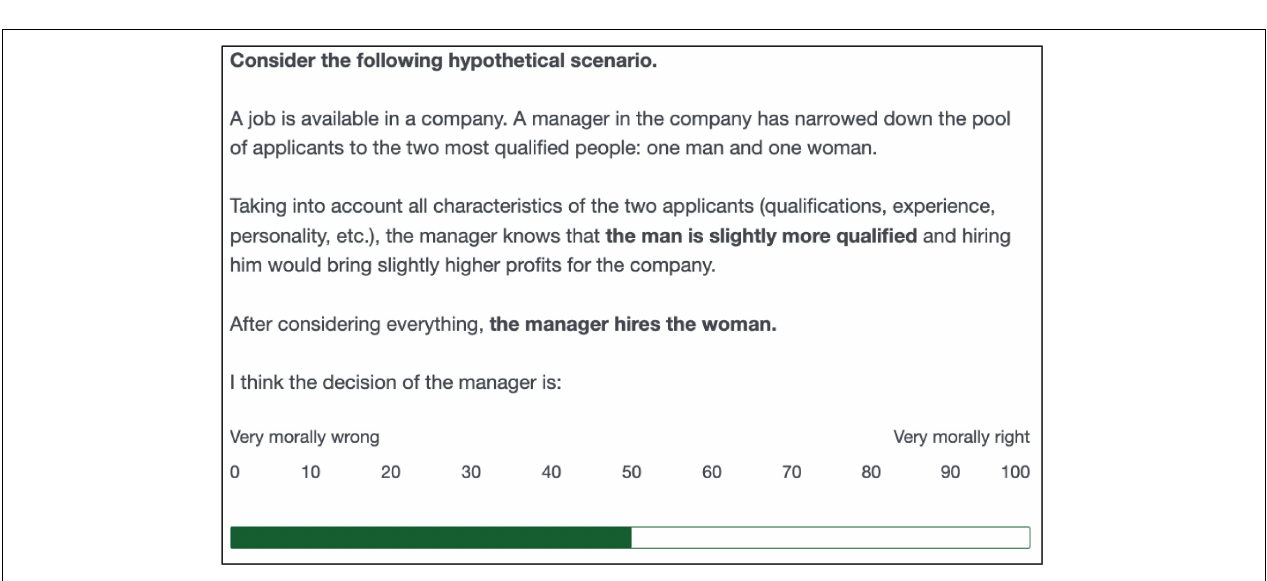
FIGURE 1 | Structure of survey.